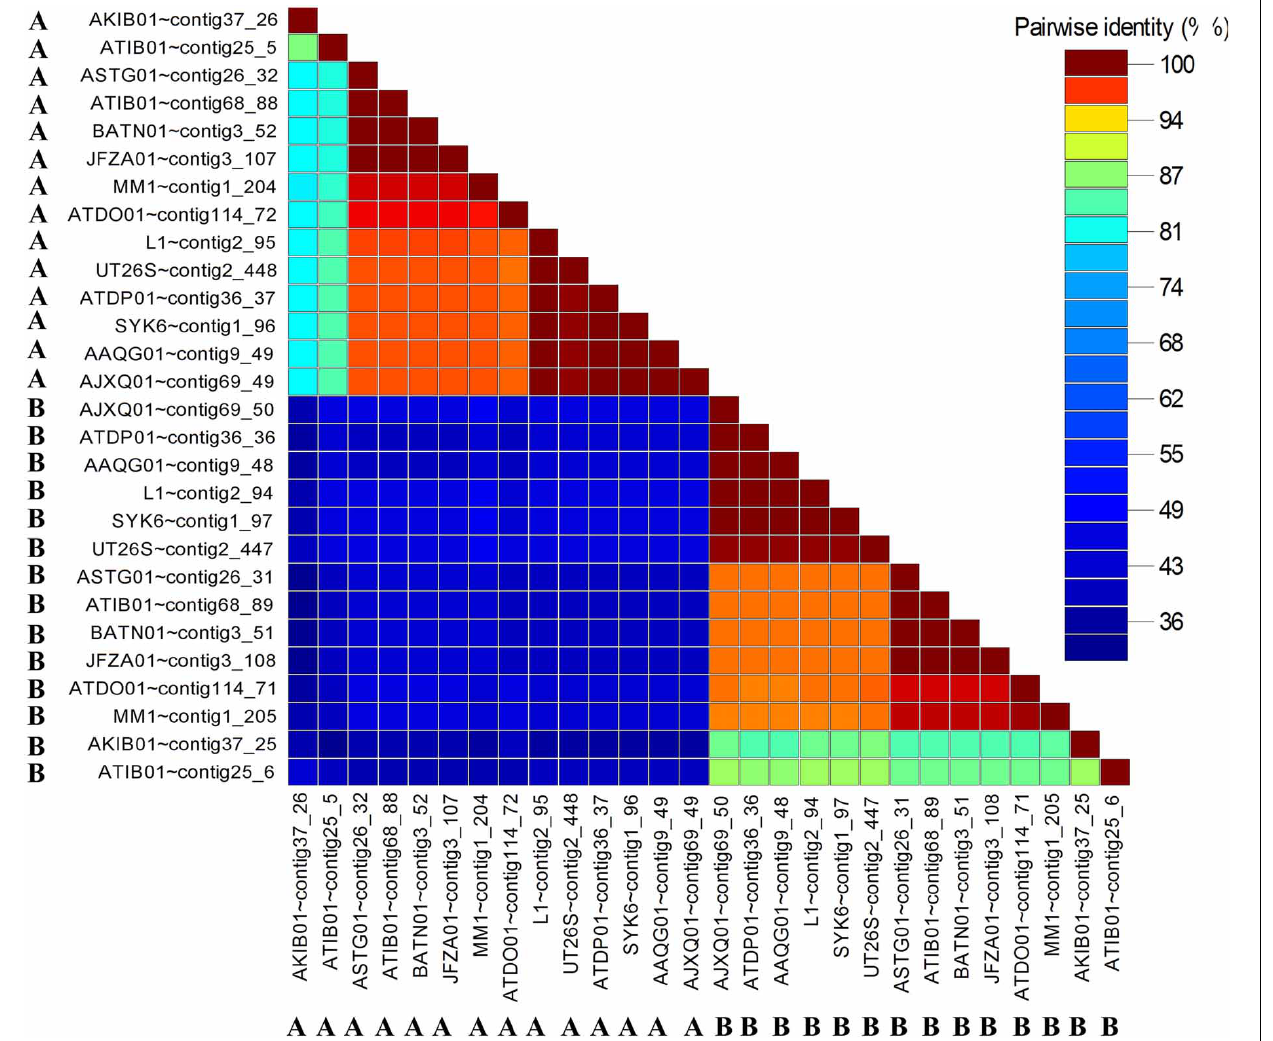
luxR-luxR-luxI . The genes coding for LuxR homologs with the same symbol and color were convergently oriented with respect to each